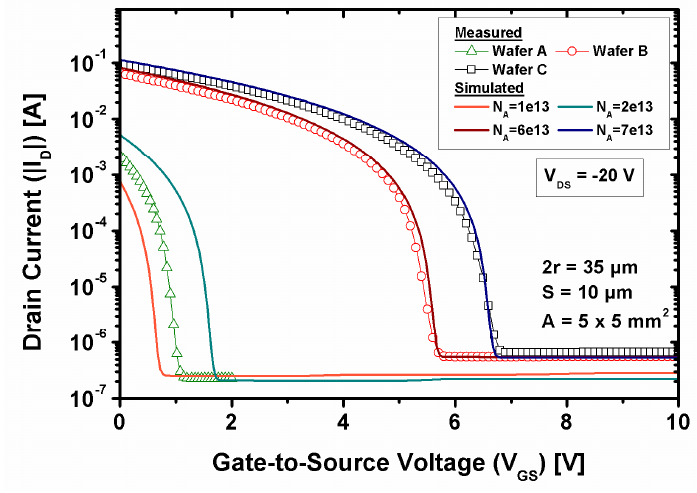
Figure 8. Measured transfer characteristic curves (| I D | vs. V GS at V DS = − 20 V) for several representative V-JFET samples, with 2 r = 35 µ m, S = 10 µ m and A = 5 × 5 mm 2 , coming from different wafers (A, B, and C), and compared with the corresponding simulated curves for different N A values.